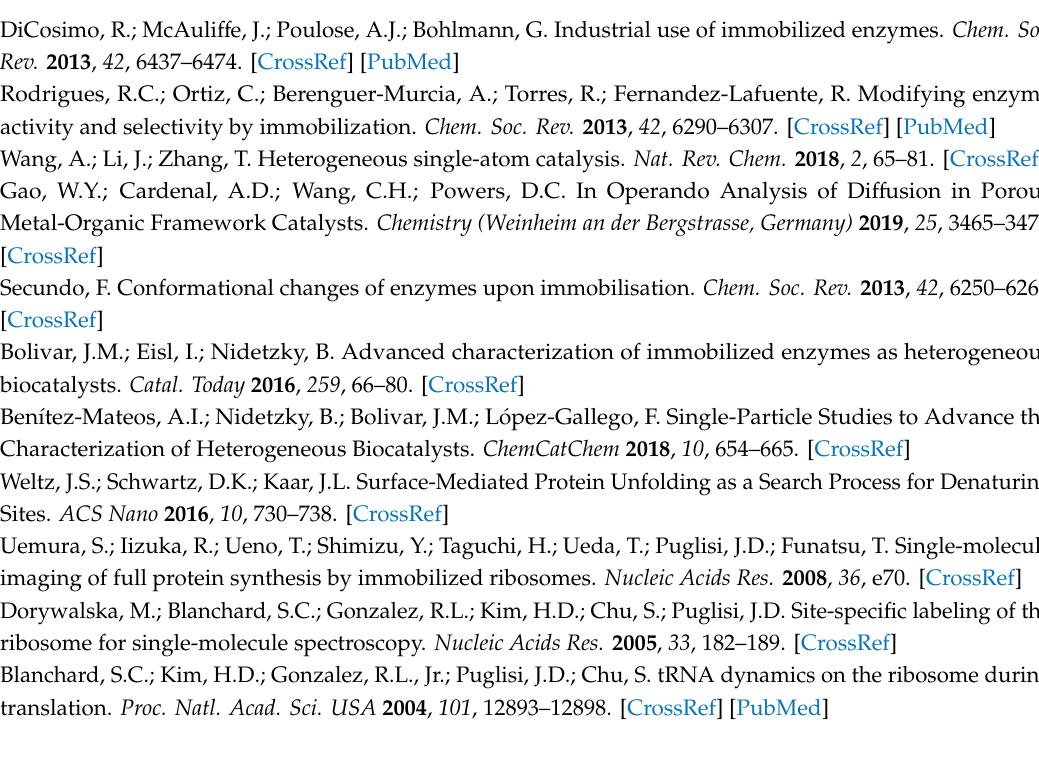
Table S1. Immobilization parameters of His-BsADH co-immobilized with NADH on agarose microbeads 9 activated with cobalt chelates; Figure S1. E ff ect of the maximum intraparticle cofactor concentration [Pf] on the kinetic parameters of the 11 immobilized; Figure S2. Example of lag-phase removal for one single-particle experiment; Figure S3. Removal of outlier points from one single-particle experiment; Figure S4. Calculation of volumetric fluorescence intensity; Figure S5. Graphical explanation of how to calculate the volumetric fluorescence intensity; Figure S6. Cofactor distribution across the surface of agarose microbeads functionalized with PEI. Author Contributions: F.L.-G. conceived the experiments and E.M.-M. analyzed the data. E.M.-M., S.V.-L.